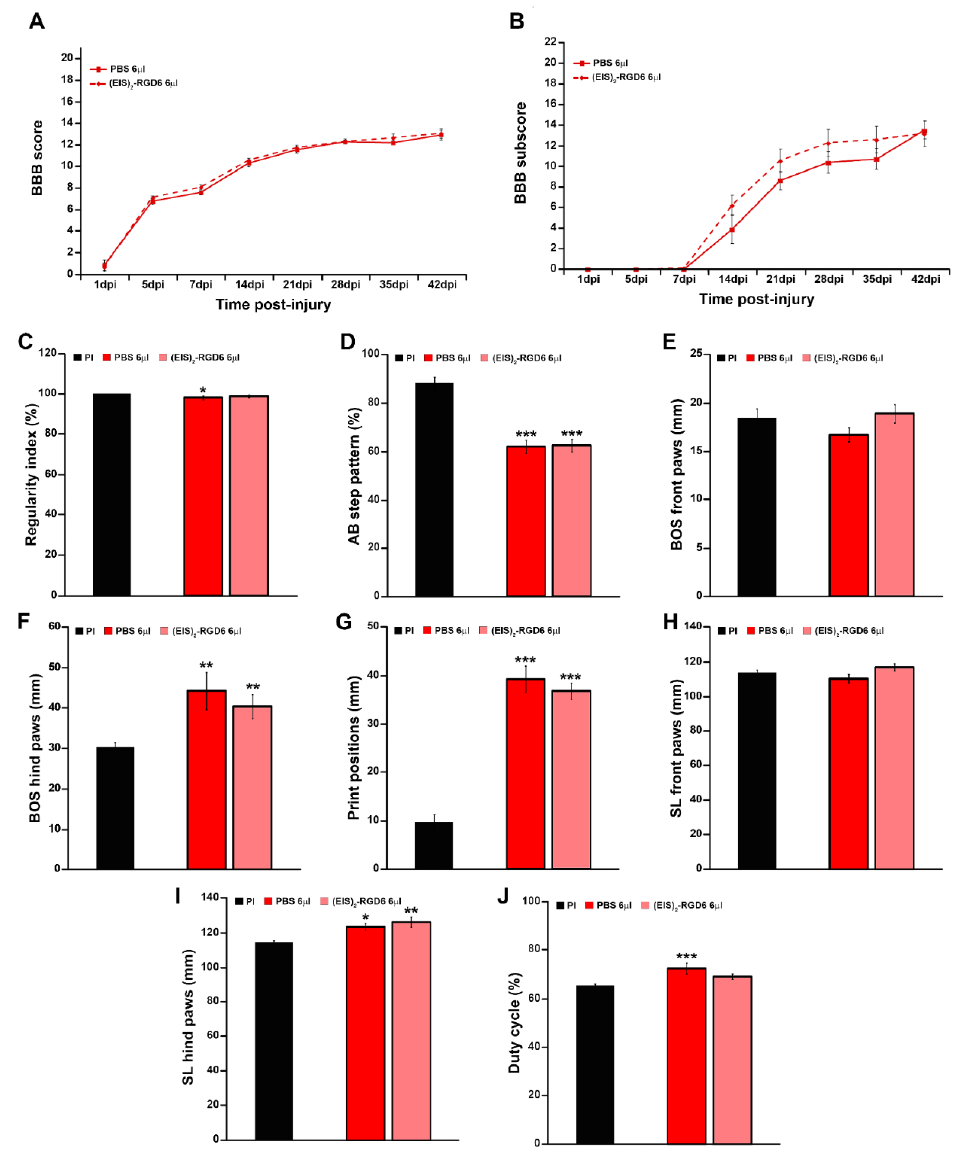
Figure 15. Evaluation of the effects exerted by (EIS) 2 -RGD6 injection in motor functional recovery. Graphs show data obtained from the evaluation of the effects exerted by (EIS) 2 -RGD6 injection in motor functional recovery in animals used to perform the experiment (EIS) 2 -RGD6 III. ( A ) Data